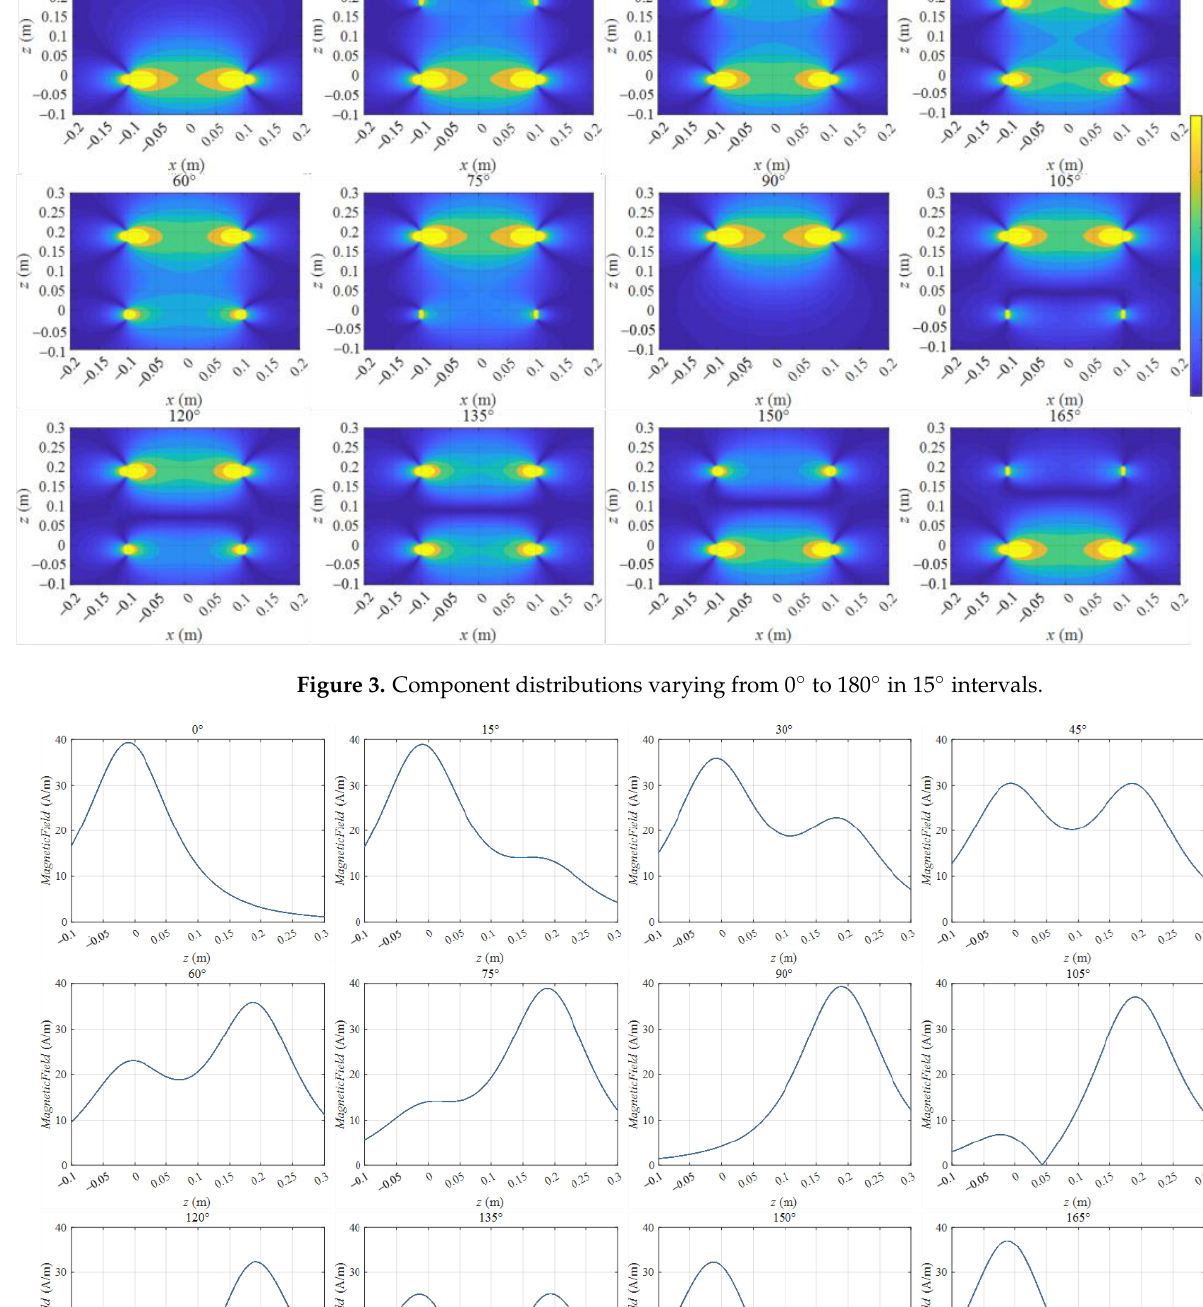
Figure 4. O n line x = 0 m from z = −0.1 m to z = 0.3 m varying from 0° to 180°. Figure 4. On line x = 0 m from z = − 0.1 m to z = 0.3 m varying from 0 ◦ to 180 ◦ From 105° to 165°, a zero point emerged on each curve of the different time phases. The zero point emerged in the whole half period, except at the degree equal to 90° or 180°. The z coordinate of the zero point varied from z = 0.05 m to z = 0.14 m when the time